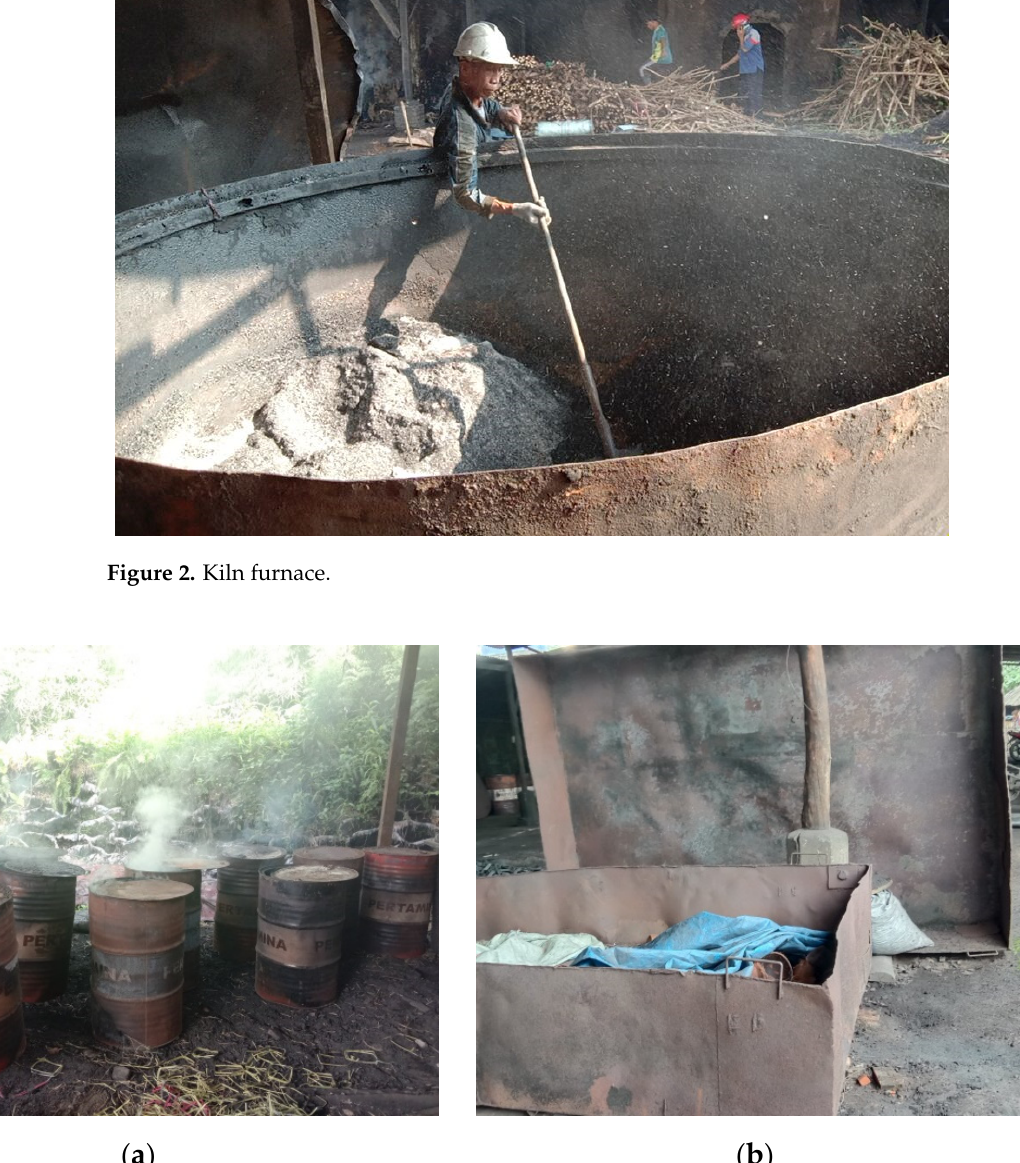
Figure 2. Kiln furnace.